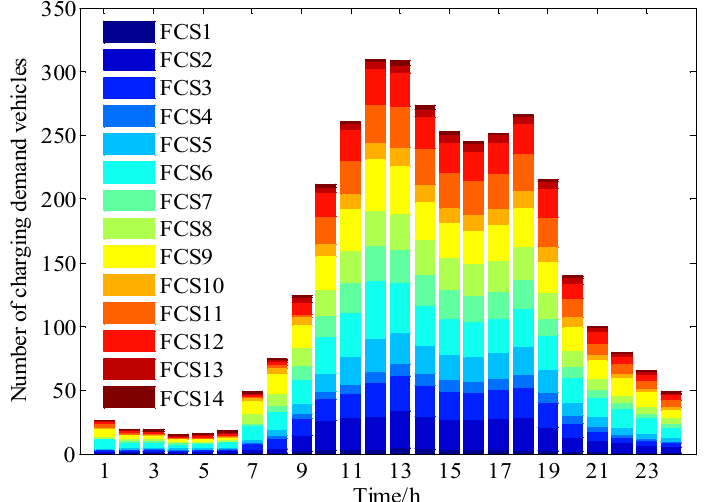
Figure 10. Temporal distribution of vehicles with fast-charging requirements.